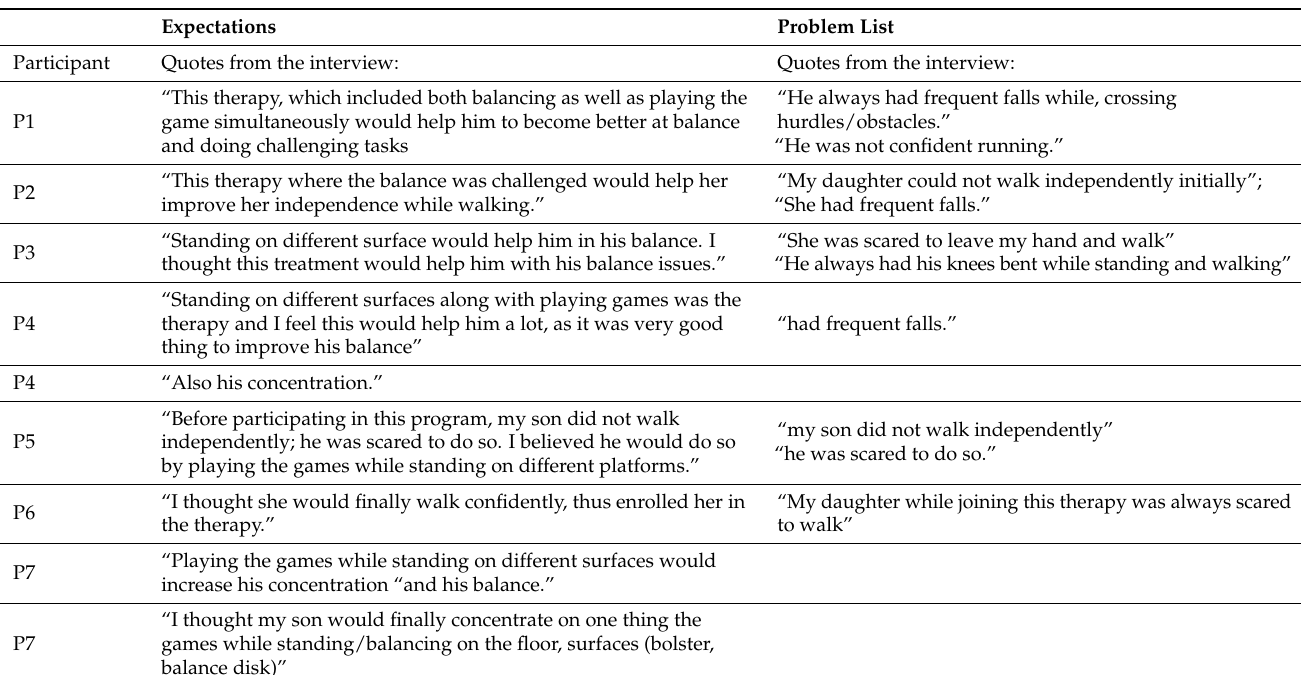
Table 2. Expectations and problem